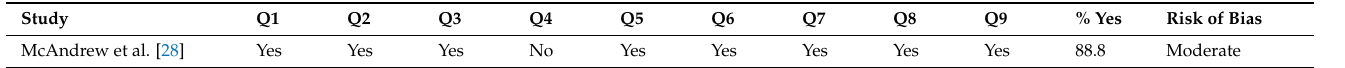
Table 7. Risk of bias assessment for quasi-experimental studies according to the JBI tool